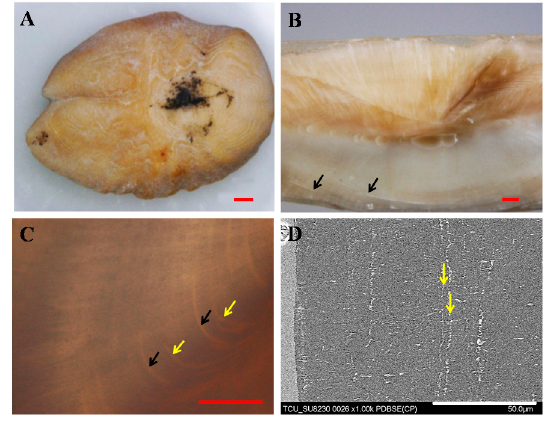
Figure 2. Micrograph of Lobianchia gemellarii (Cocco). The narrower incremental lines were unclear and irregularly observed ( B – D ). The long-period incremental lines (average 41 µ m: yellow arrows and average 66 µ m: black arrows) were observed ( B,C ). Digital microscopy images ( A : otolith surface, B : cross-sectional image). Polarizing micrograph of the ground specimen ( C ). SEM micrograph ( D ). Scale bar: 500 µ m ( A ), 100 µ m ( B ), 50 µ m ( C , D ).